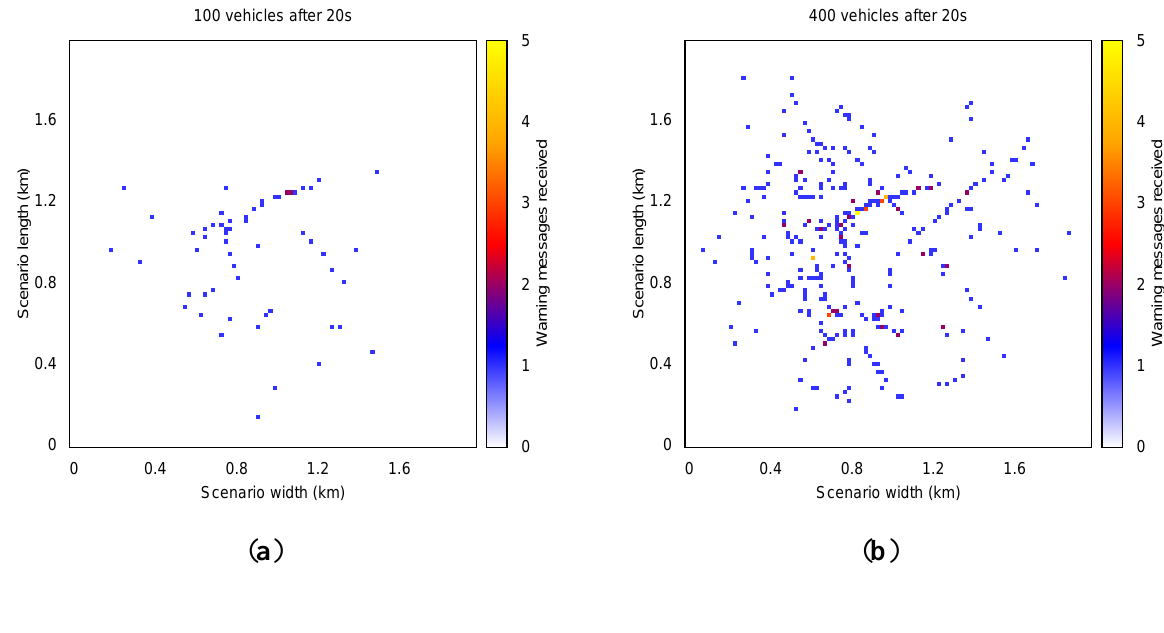
Figure 6. Evolution of the warning message dissemination process in the Rome scenario after 20 s, when simulating ( a ) 100 and ( b ) 400 vehicles.